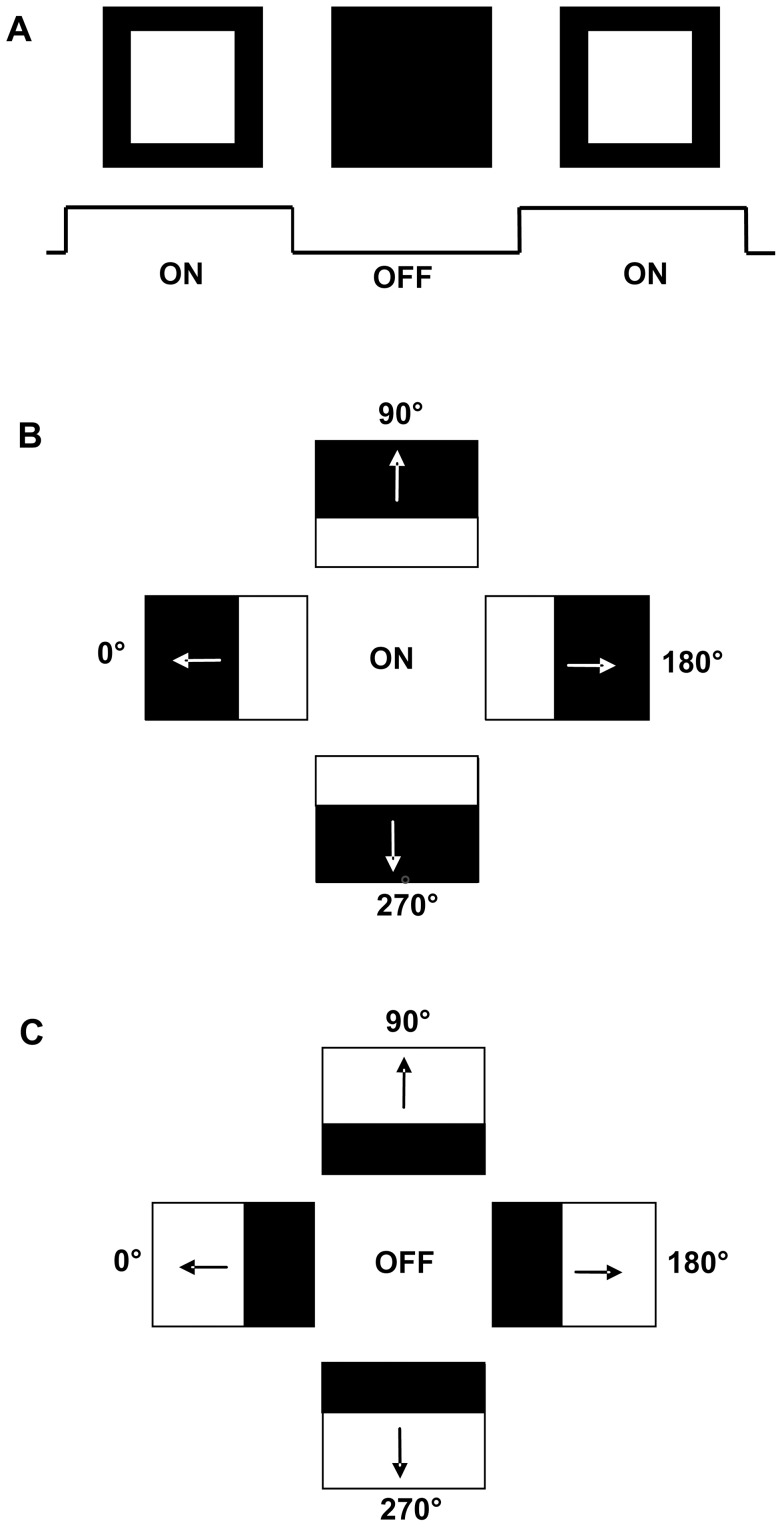
Schematic demonstration of the visual stimuli used in the present study.A: stationary flash stimulus, duration of the presentation of the bright (ON) and the dark (OFF) monitor lasted for 1s each. B: moving ON stimulus. A light edge moved across the dark monitor until it was fully bright in the four cardinal directions. C: moving OFF stimulus. A dark edge moved across the bright monitor until it was fully dark in the four cardinal directions (for further description see methods).